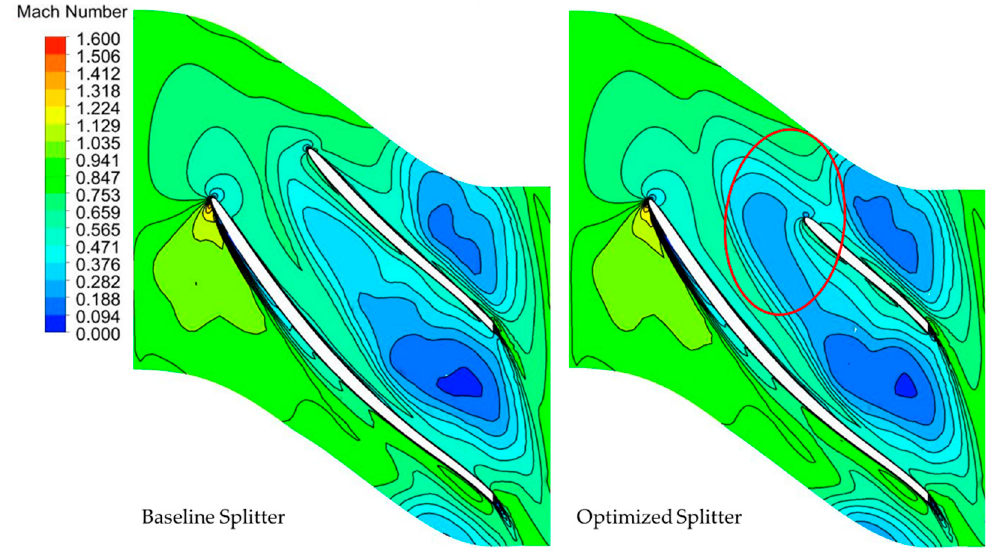
Figure 23. Mach number distribution for span 0.8 at the blade-to-blade contour.